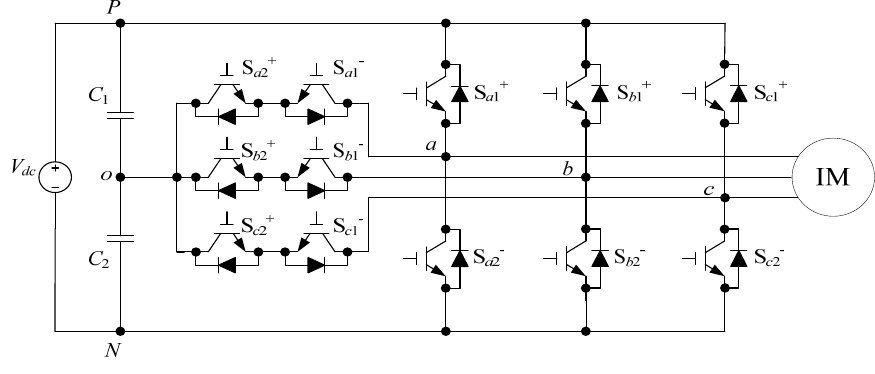
Figure 2. The architecture of three-level T-type inverter.